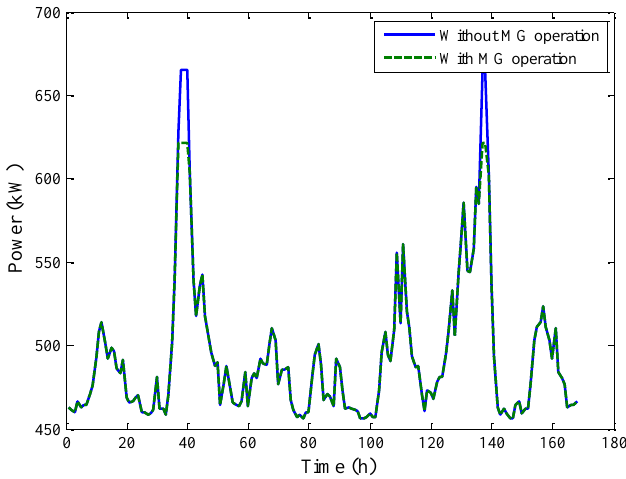
Figure 13. Power demand during the first week.